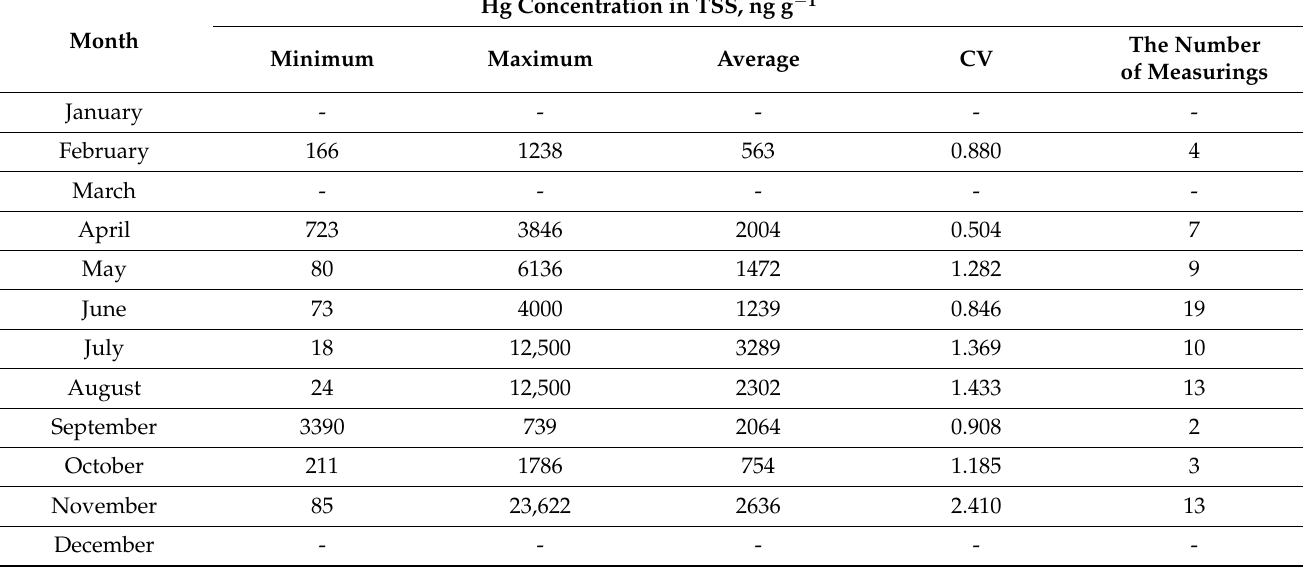
Table 3. The concentration of Hg in the suspended matter of the Crimean saline lakes in different months of the